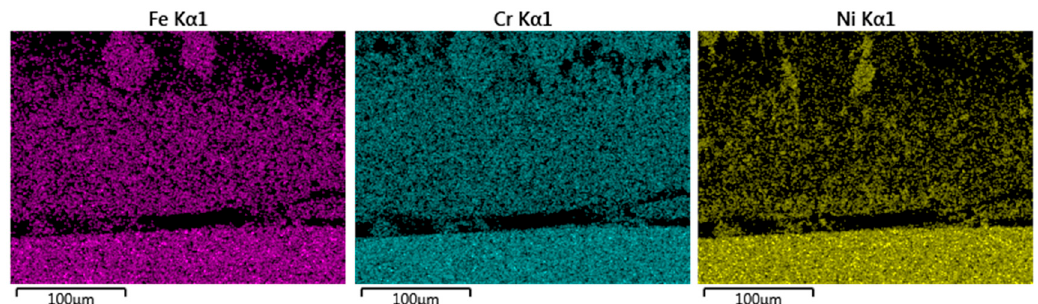
was increased relative to the rest of the layer. The concentration of Cr and Fe was approximately half